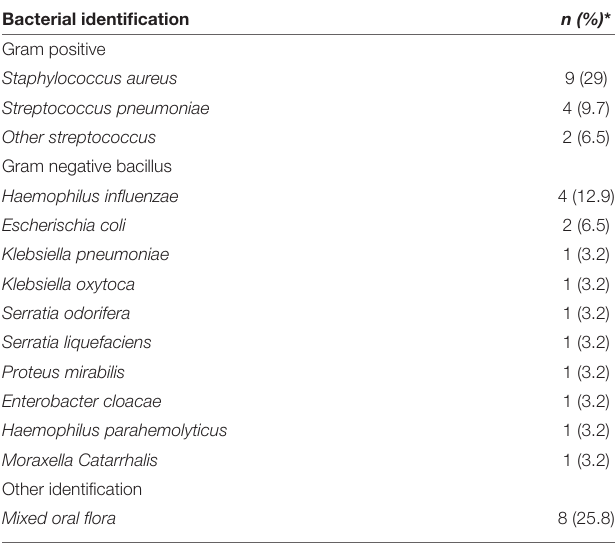
TABLE 3 | Microbial identification in ICU admission bronchial sampling. Bacterial